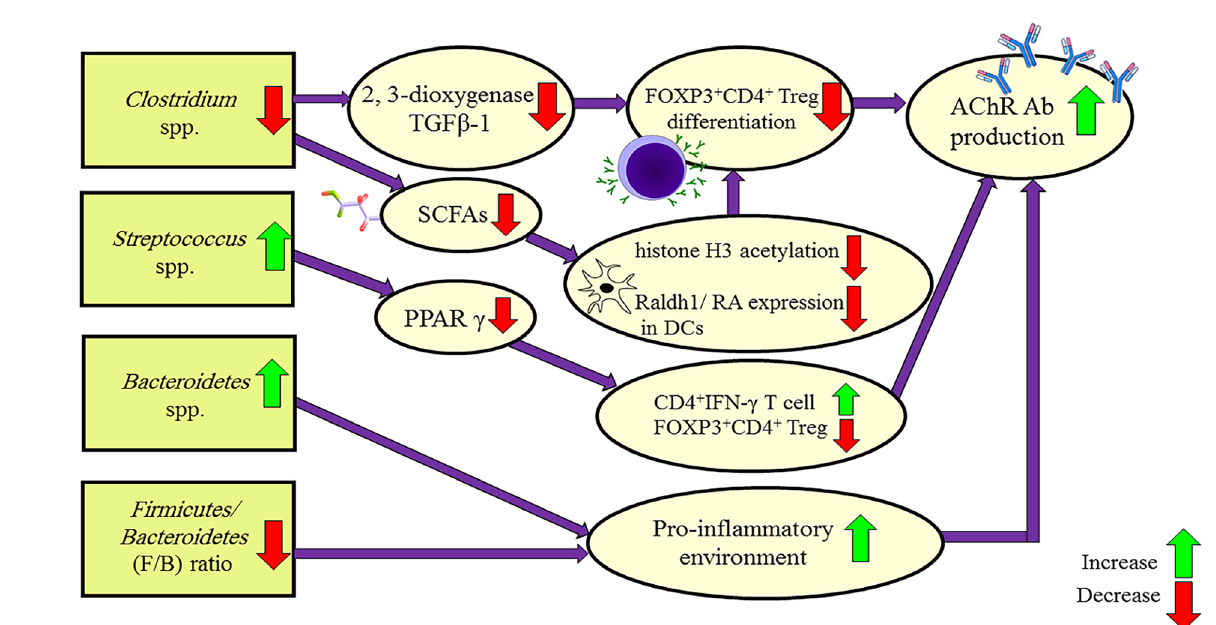
Figure 2. Mechanisms leading to MG pathology by the gut microbiome of MG patients. Raldh1: retinal dehydrogenase isoform-1; RA: retinoic acid; Ab: